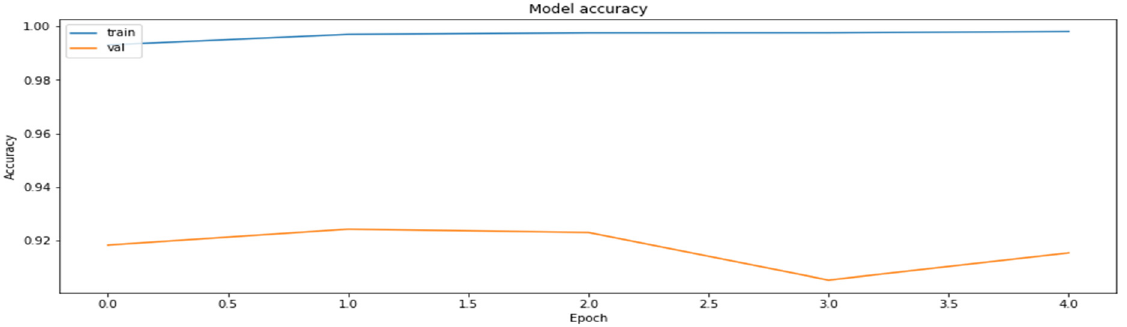
Figure A5. The loss function value for the training and the validation datasets obtained during the training of the model with the weights clustered with KMeans++ initialization of 256 centroids.